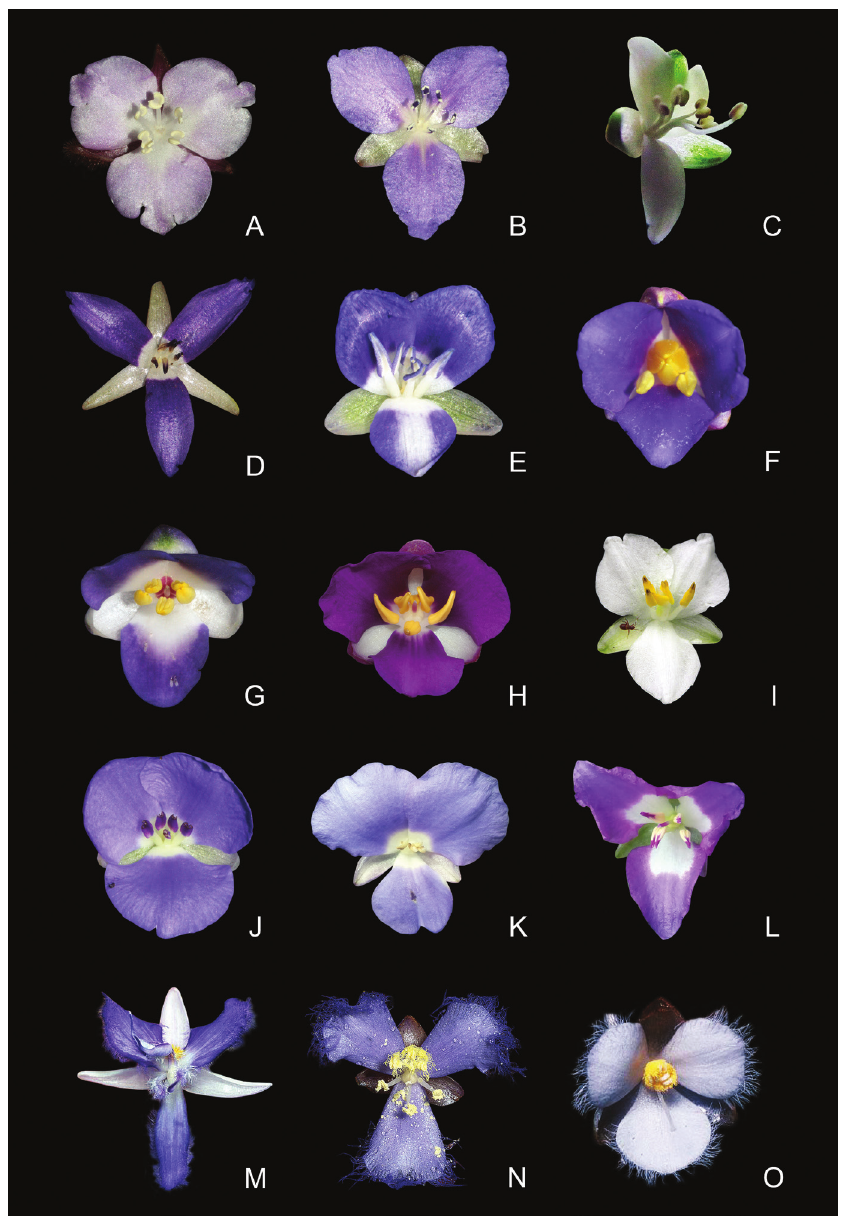
Figure 1. Floral morphology of subtribe Dichorisandrinae s.l. A – C Siderasis Raf. emend M.Pell. & Faden: A S. fuscata (Lodd.) H.E.Moore B S. albofasciata M.Pell. C S. zorzanellii M.Pell. & Faden. D – L Dichorisan- dra J.C.Mikan: D D. acaulis Cogn. E D. hexandra (Aubl.) C.B.Clarke F D. thyrsiflora J.C.Mikan G